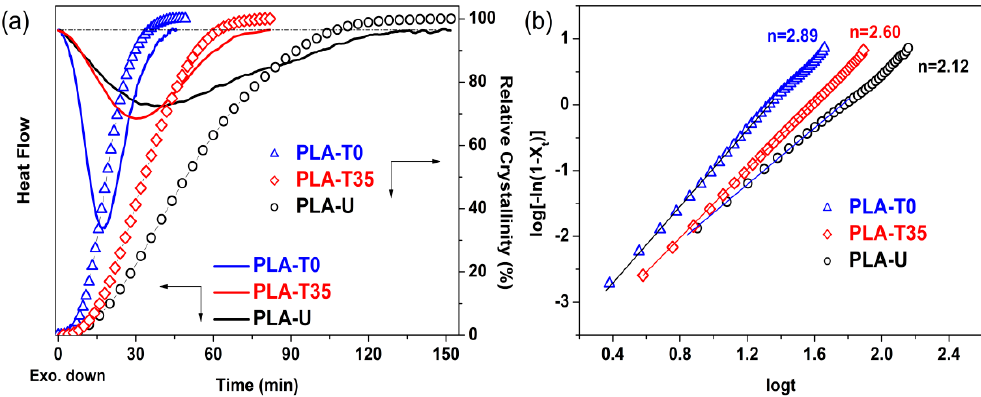
Figure 1. DSC cooling curves for untreated PLA sample (PLA-U) at a cooling rate of 2.5 °C/min from the melt.